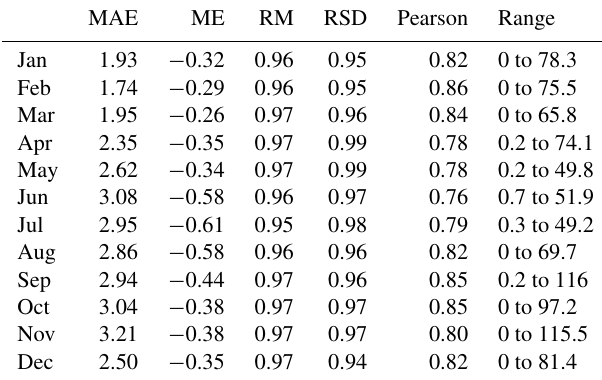
Table 3. The leave-one-out cross-validation (LOO-CV) statistics for precipitation, showing the goodness of fit between measure- ments and estimates of monthly aggregates. MAE: mean absolute error; ME: mean error; RM: ratio of means; RSD: ratio of standard deviations. The results were rounded to two decimal